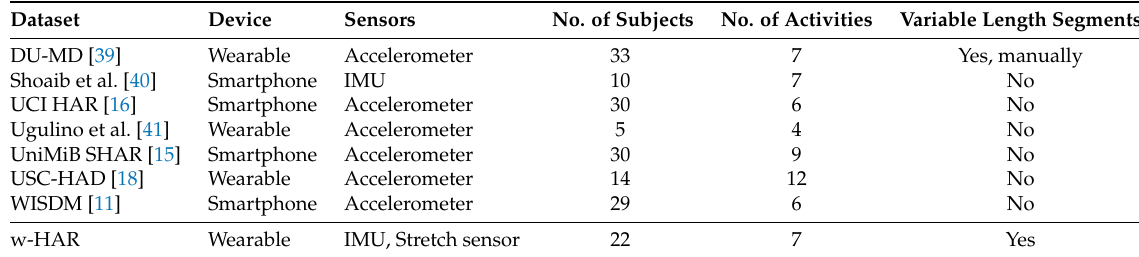
Table 5. Comparison with existing HAR